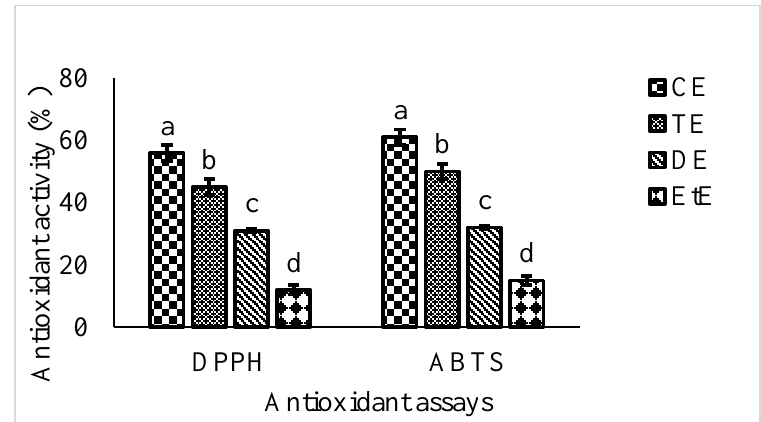
Figure 1. Antioxidant activity of di ff erent extracts of RC. CE: Chloroform extract, TE: Toluene extract, DE: Dichloromethane extract, and ETE: Ethyl ether extract. Letters a–d indicates the significance di ff erence among di ff erent extracts of